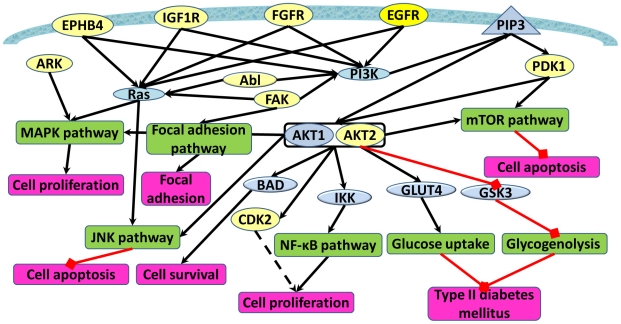
Interactions between predicted off-targets and PI3K/Akt, MAPK, JNK, NF-κB, mTOR, Glucose uptake, and Glycogenolysis pathways.Yellow circles represent predicted off-targets. Blue circle represents intermediate proteins. Green squares represent pathways. Pink squares represent cellular effects. Black lines represent activation. Red lines represent inhibition. Black dashed lines represent a dual effect (activation or inhibition).